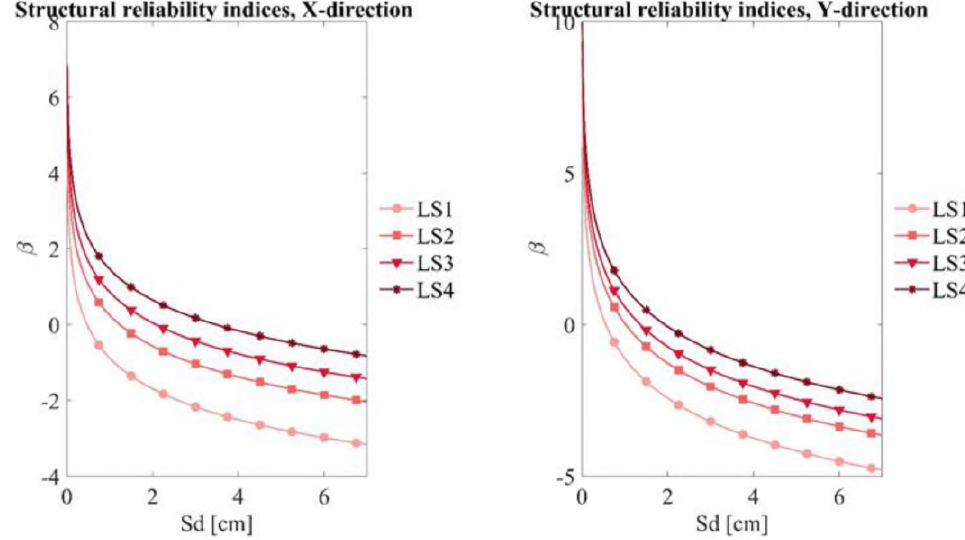
Figure 18. Structural reliability indices for the limit states of interest, for the two